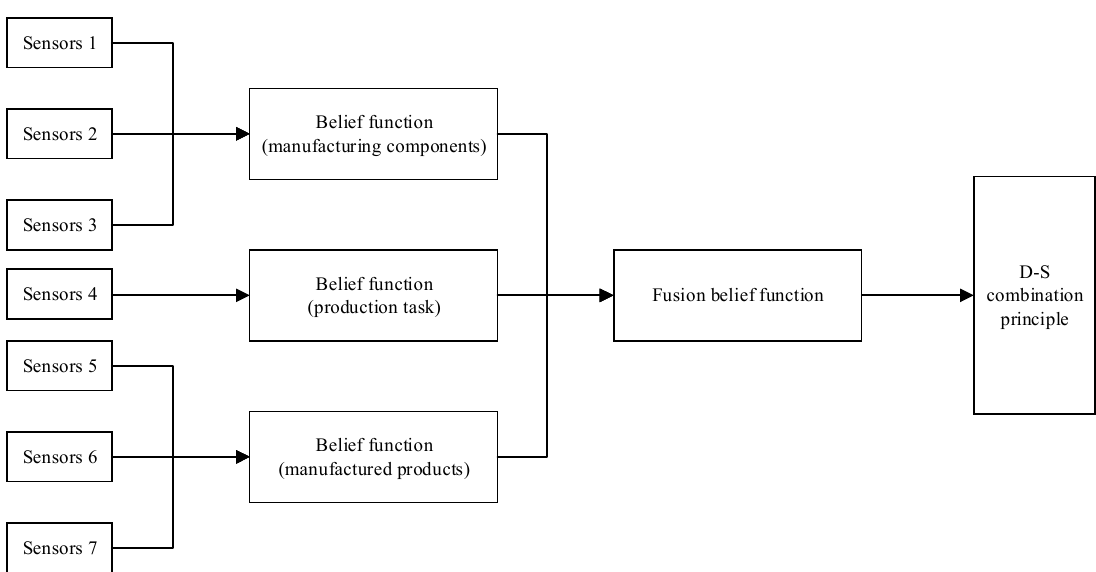
Figure 5. Fusion diagnosis process of manufacturing systems.